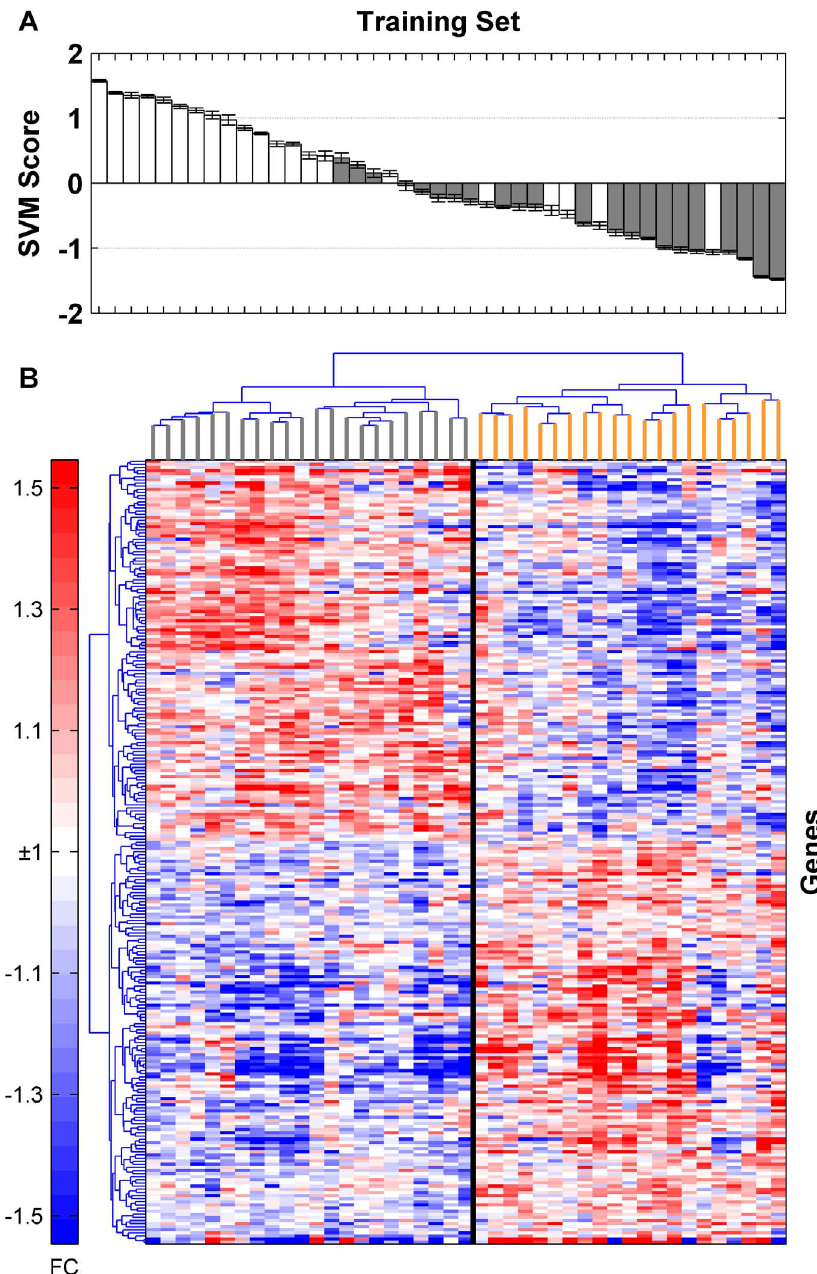
Figure 1. Classification of the training set samples. A) Support vector machine (SVM) scores based on the 251-gene signature assigned to HIV/ TB (white) and HIV (grey) samples, where a positive score corresponds to an HIV/TB prediction and a negative score to a control, and B) Hierarchical clustering using the 251 probes clearly separate the samples into two arms, with mono-infected HIV patients (grey) clustering to the left and co- infected HIV/TB patients (orange) clustering to the